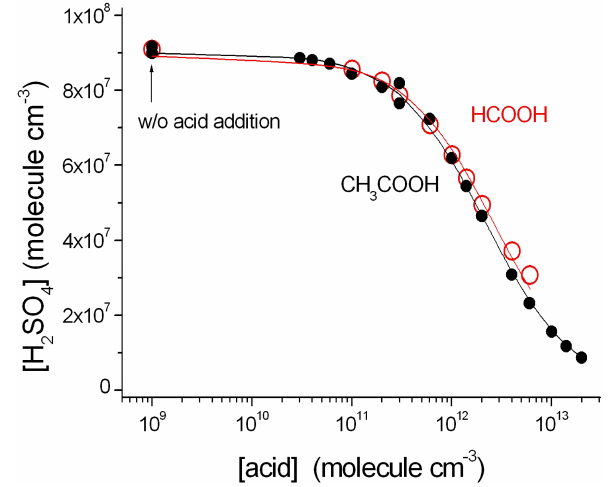
Figure 4. Experimental data from the competitive reaction kinetics experiments, sCI + SO 2 vs. sCI + acid, sCI ≡ (CH 3 ) 2 COO (from TME ozonolysis). The lines show the best-fit result of the non-linear regression analysis from Eq. (7).